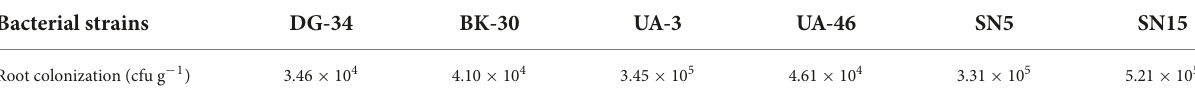
( Table 7 ). The plant inoculated with bacterial consortium T